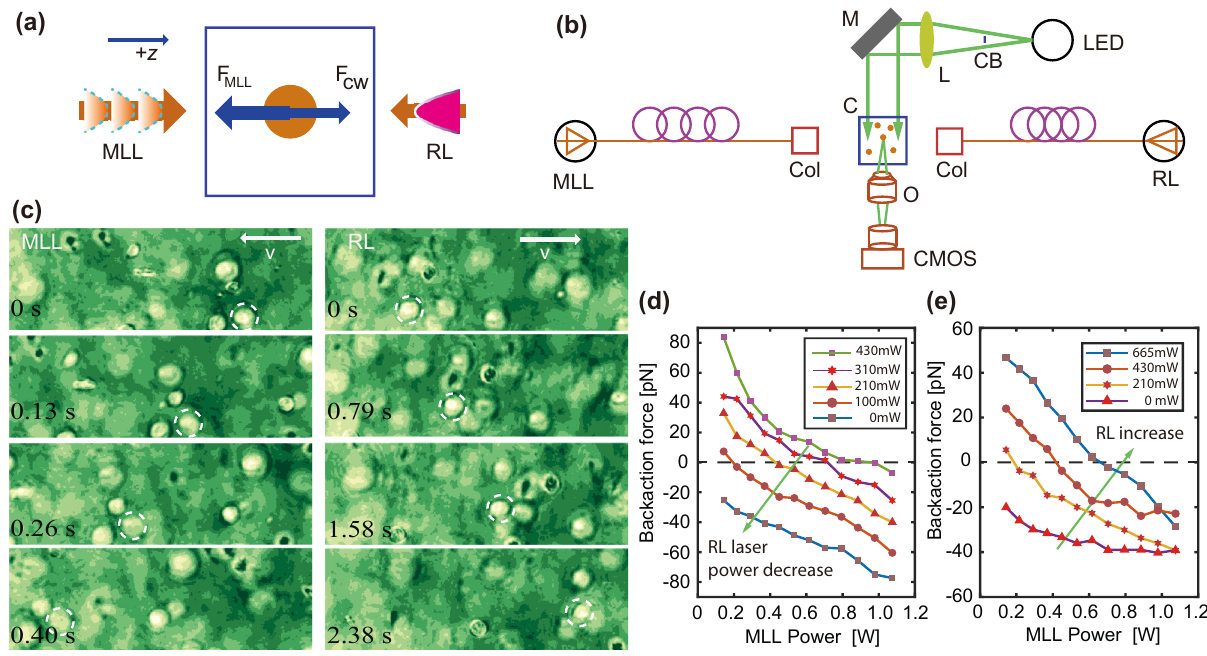
Figure 4: Force balance on cancer cells under counter-propagating beams. (a) Demonstration of the backaction force on the microsphere exerted by the counter-propagating beams. (b) Experimental setup with MLL and Raman lasers performing backaction force from opposite directions. The particle motion was observed by an orthogonal microscope under bright field. MLL, mode-locked laser; C, cuvette; RL, Raman laser; M, mirror; L, lens; CB, central block; O, objective; LED, light emitting diode. (c) Motion snapshots of live MDA-MB231 cancer cells under paired beams with MLL laser (left) or the Raman laser (right, wavelength of 1.65 μ m) dominant suggest opposite motion directions. The average speed for the cancer cell marked in dashed circle moving towards left (right) is ∼ 482.2 μ m/s ( ∼ 59.5 μ m/s). (d) The optical force for the polystyrene microsphere of 15 μ m diameter as function of the MLL laser power with the Raman laser kept fixed at 0, 100, 210, 310, and 430 mW respectively. The particle motion direction reverses once the power from the Raman laser is strong enough to provide greater backaction force towards the right. (e) The large-scale optical manipulation of the MDA-MB231 cells using the counter-propagating beams suggests the balance of the cancer cell under proper combination of the power of the two